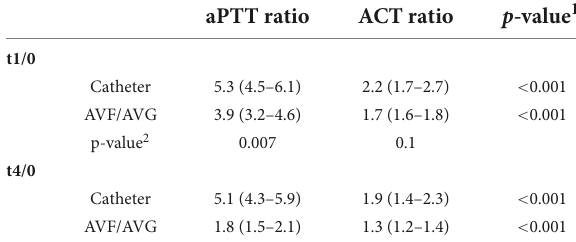
TABLE 3 Activated partial thromboplastin time (aPTT) and activated clotting time (ACT) ratios at t1 and t4 according to dialysis vascular